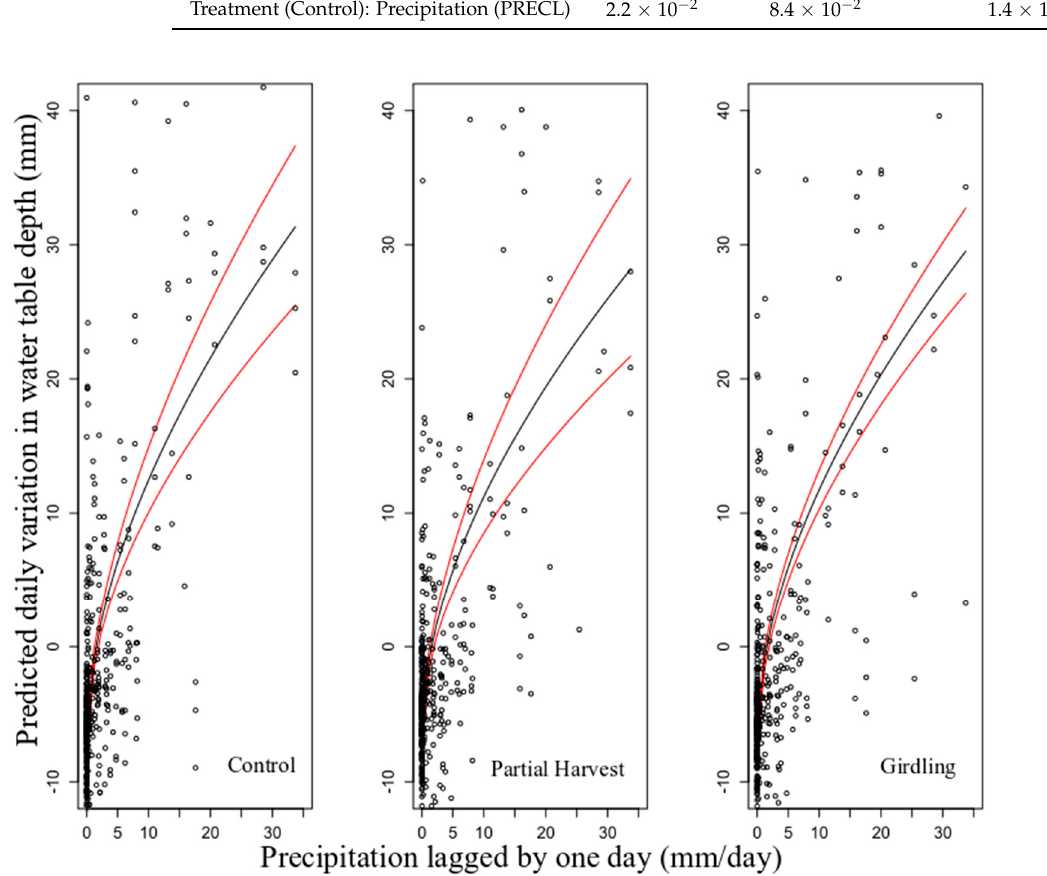
Figure 6. Predicted daily variation in water table depth following silvicultural treatments, based upon precipitation lagged by one day (mm/day) and silvicultural treatment (Control, Partial harvest and Girdling). Model-averaged predictions using the entire set of candidate models are included with 95% CI. Open circles correspond to the original observations. Note that in this figure, daily variation in water table depth was back ‐ transformed from square ‐ root values. The figure shows the effect of variables having the greatest influence on the response variable.